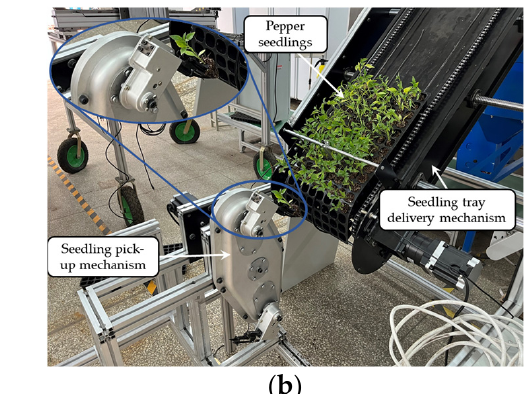
Table 4. Results of the seedling sampling test of pepper